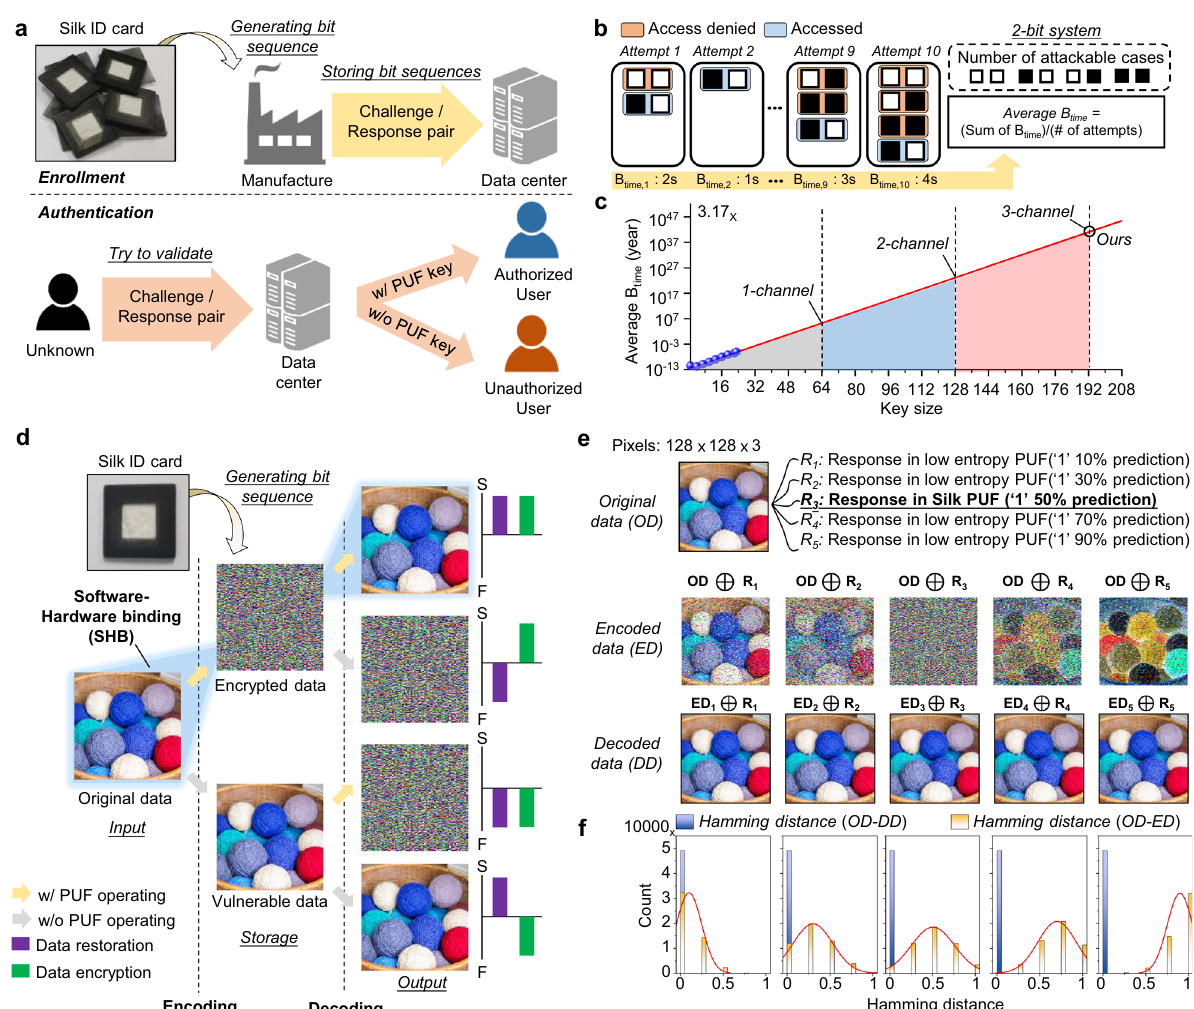
Fig. 6 Applications of the LOP-PUF: authentication and data encoding/decoding. a Schematic illustration for authentication. ‘ Enrollment ’ is the step where the manufacturer registers the PUF keys from silk ID cards in the data center. ‘ Authentication ’ is the process for the validation of unknown users using stored PUF keys. b Illustration of a brute force attack test for estimating the defense ability of the authentication system by substituting a random key for fake authentication. The average break time, B time , is calculated using the individual B time values for ten attempts. c Graph of the average break time using the brute force attack in our proposed system as a function of the key size. Using three-color space allows the creation of a large number of key sizes for a strong security level. d Description for an application of data encryption in the LOP-PUF. Successful data encoding and decoding with encryption are possible only when software and hardware binding is ensured. With operating PUF, input data are stored as encrypted and the stored data are decoded properly. Without operating PUF, the input data are vulnerable and the stored data are illegible. The purple and green boxes indicate success or failure of the data restoration and encryption depending on the operation of the PUF. The letters ‘ S ’ and ‘ F ’ mean success and fail, respectively. e Data encryption and decryption in the pictured materials using fi ve responses with different ‘ 1 ’ -bit ratios of 10, 30, 50, 70, and 90% where the PUF with a half ratio of '1' bit is generated by the LOP-PUF using silk. f Hamming distance (HD) of the original data vs. encoded data (OD-ED) and the original data vs. decoded data (OD- DD). The red solid lines refer to the HD distributions of the